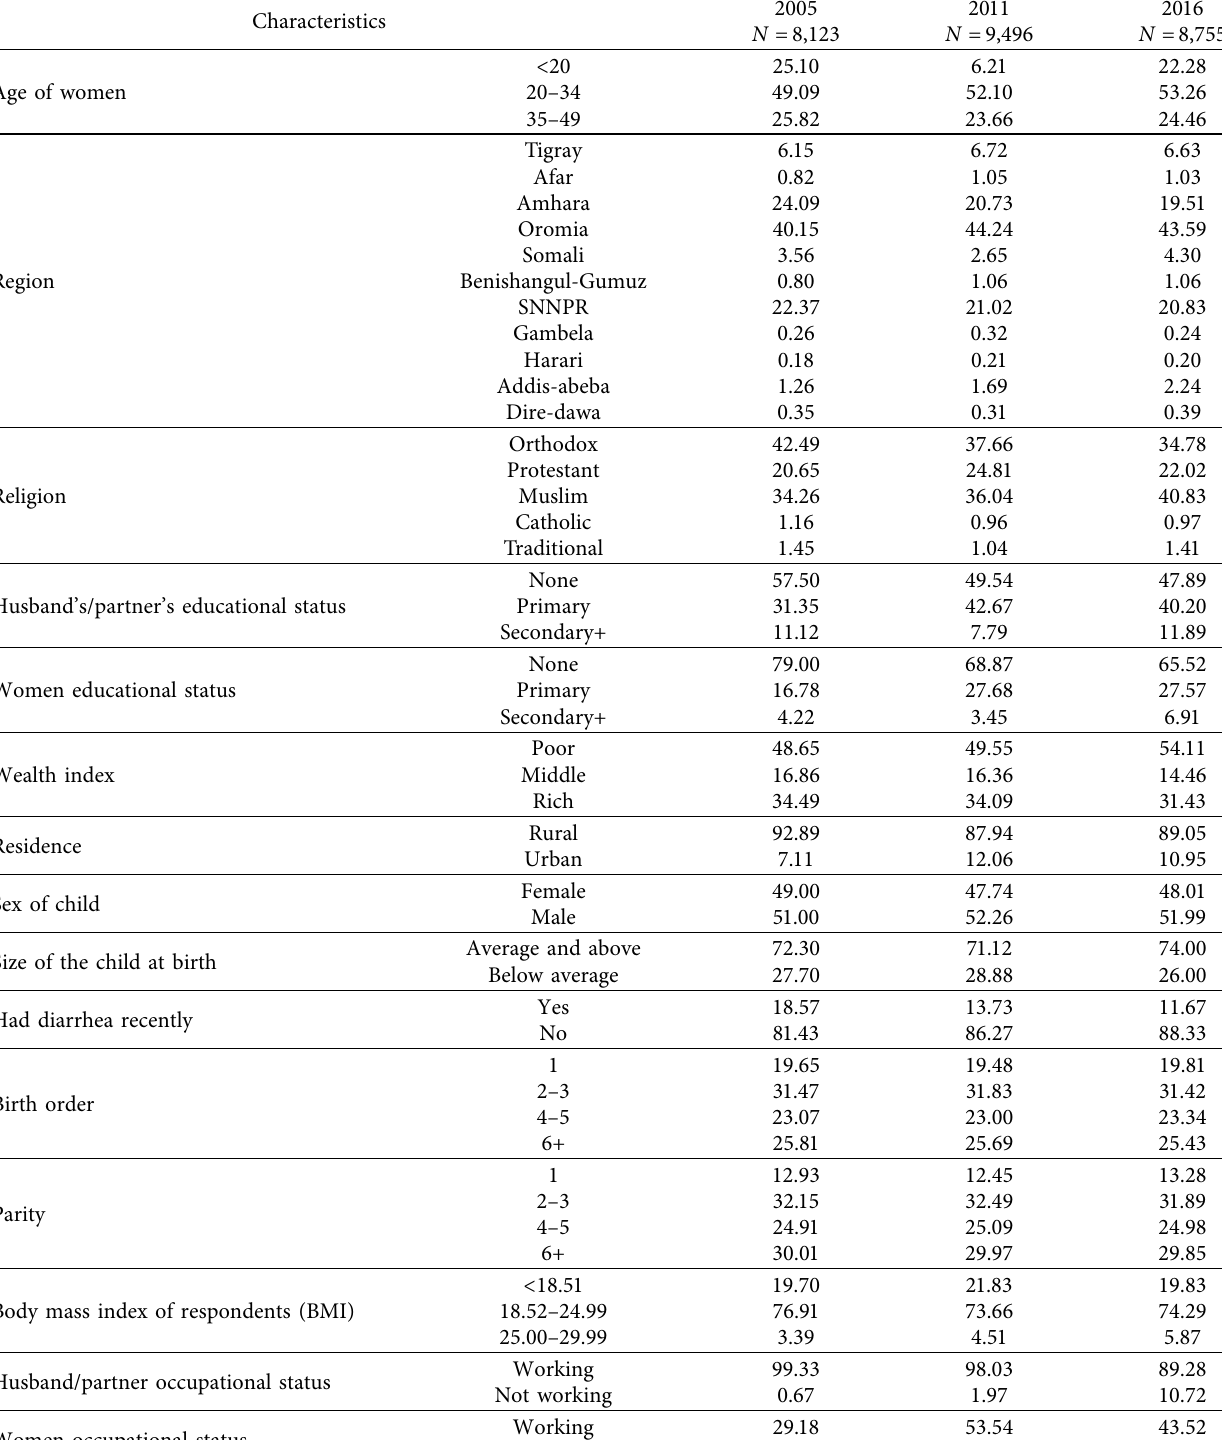
Table 1: Percentage distribution of sociodemographic characteristics among respondents from 2005–2016 EDHS.